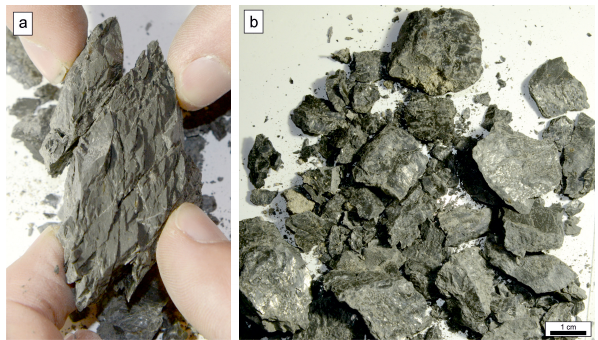
Figure 4. Intact scaly clay sample A5 (a) and loose flakes (b) after gentle disintegration by